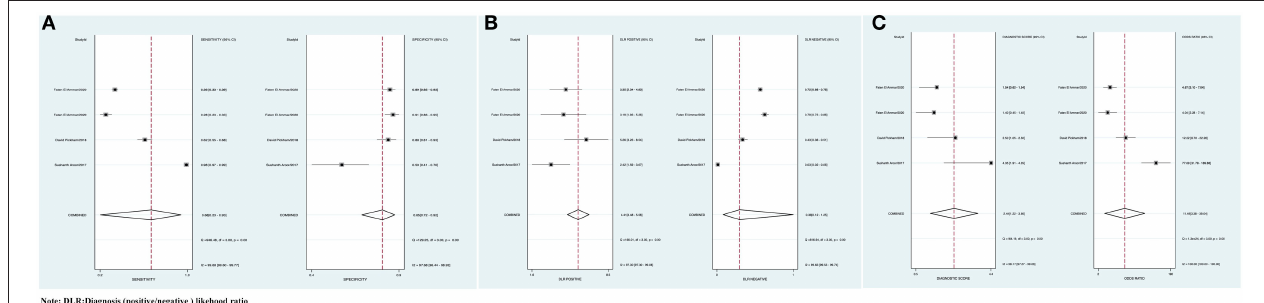
FIGURE 8 | Deeks’ funnel plot asymmetry test for BEFAST.